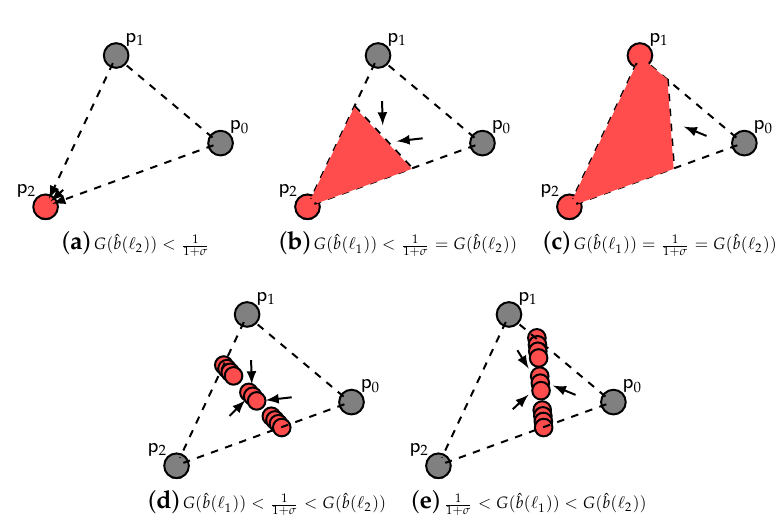
Figure 3. Dynamics for a linear f ( · ) , where (cid:96) d > (cid:96) c . Set of strategies S = { 0,1,2 }